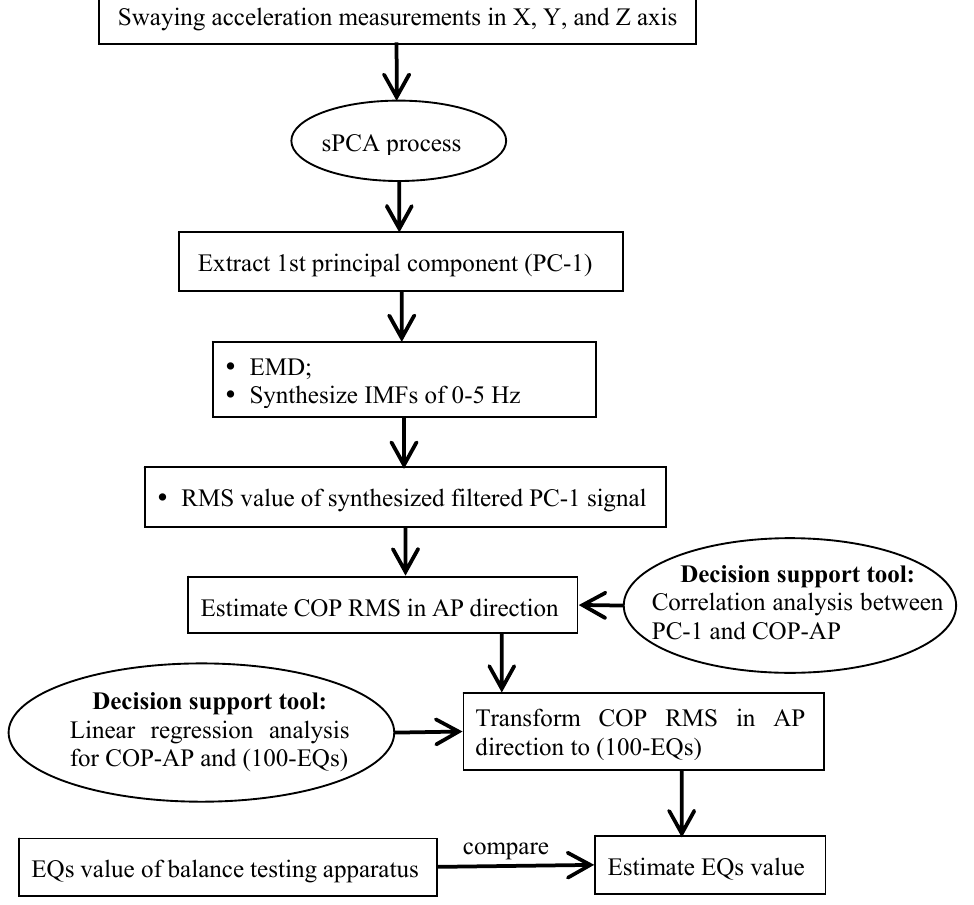
Figure 12. Regression analysis for RMS values of COP measurement in the AP direction and the swaying level (100 EQs).